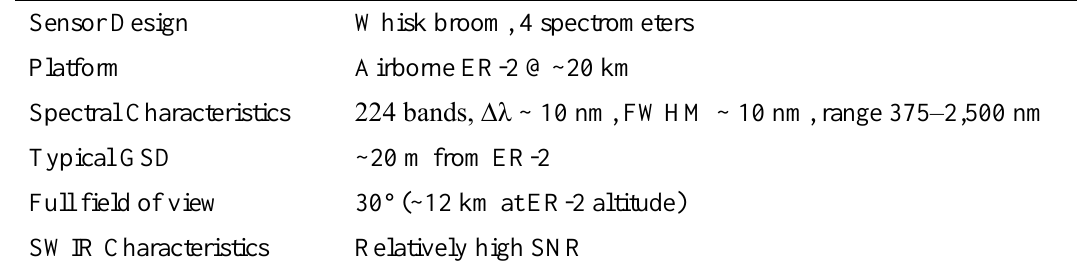
Table 1. Specification of